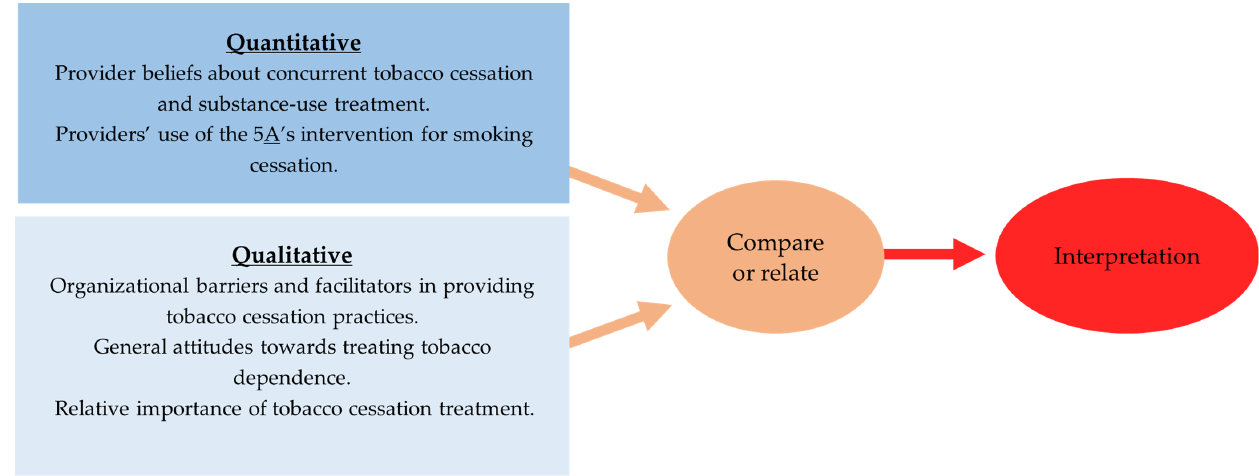
Figure 1. Convergent Mixed-Methods